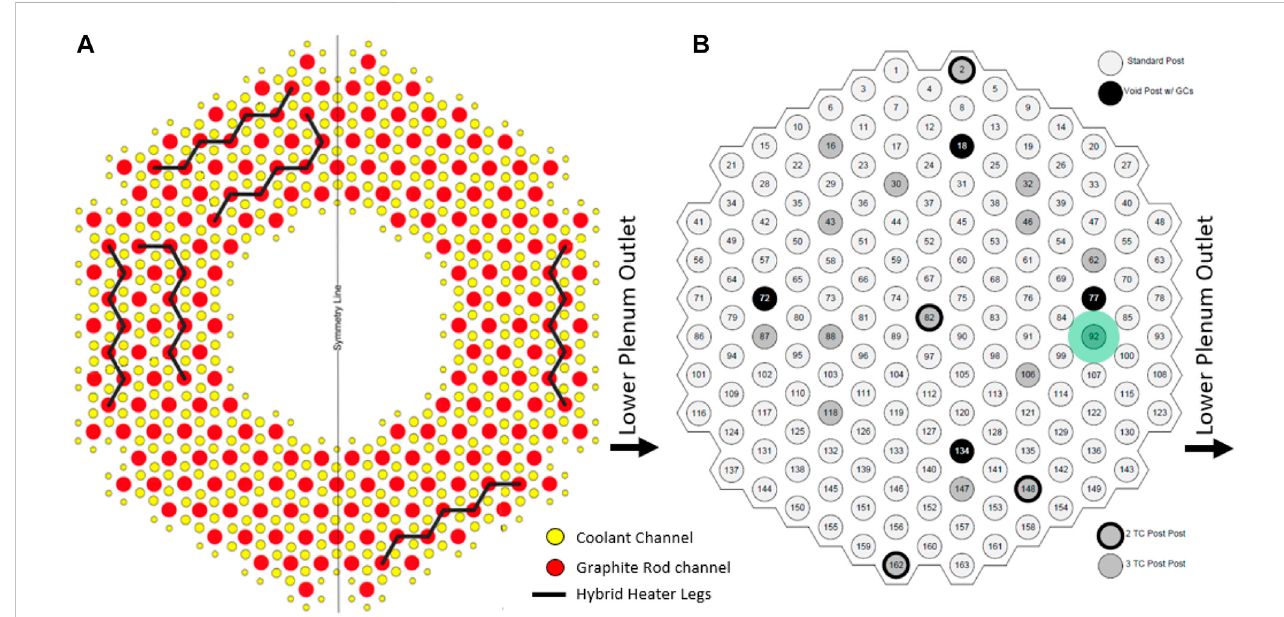
FIGURE 10 Power, lower plenum post #92 temperatures, and circulator speed distributions over the duration of the test PG-28 (left) and PG-30 (right).